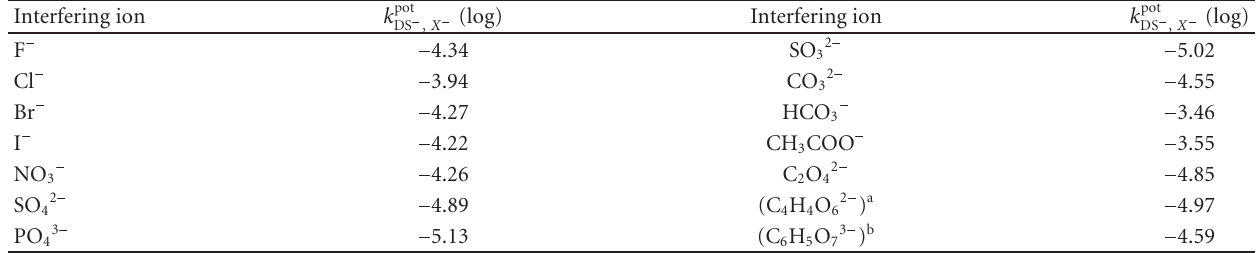
Table 3: Potentiometric selective coe ffi cients for anionic surfactant selective electrode. Interfering ion k pot (log) Interfering ion DS (cid:0) , X (cid:0)